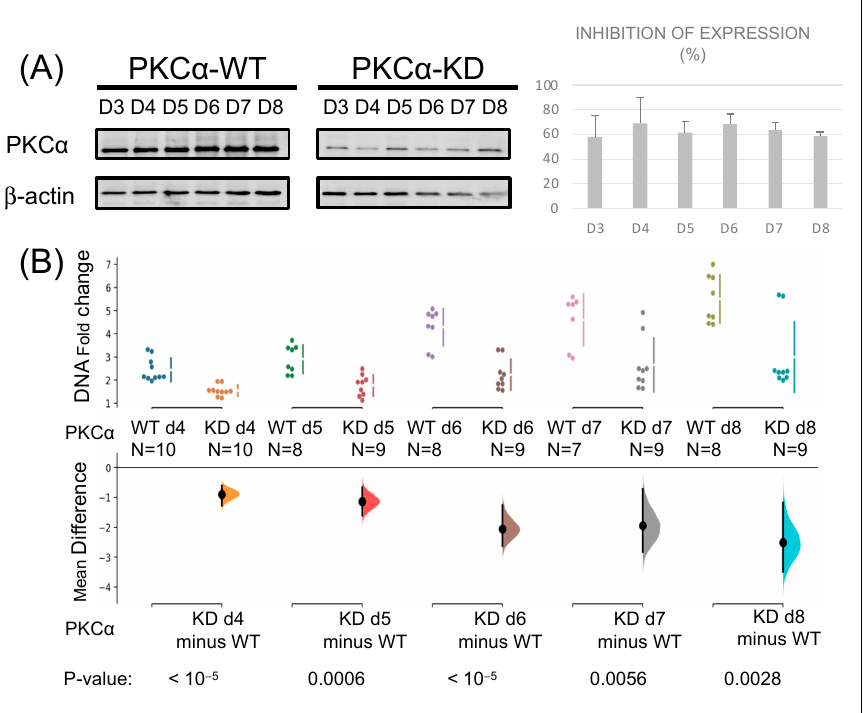
Figure 1. Knock-down of PKC α in MCF-7 cells affects their proliferation capacity: ( A ) MCF-7 cells were transfected with siRNA specific for PKC α . Protein expression was assessed by WB relative to β -actin expression at the days indicated. ( B ) Proliferation rates of PKC α -WT and PKC α -KD MCF-7 cells were measured by fluorometric DNA quantitation. The mean difference for two comparisons against the PKC α -WT and PKC α -KD cells are shown in the Cumming estimation plots (see Materials and Methods for a more extensive explanation).